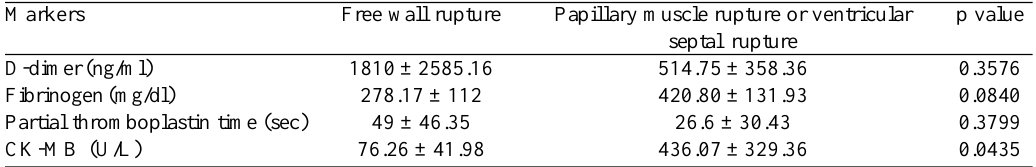
Table 3. A comparison of the the hemostatic markers and creatine kinase fraction MB between free wall rupture and papillary muscle rupture or ventricular septal